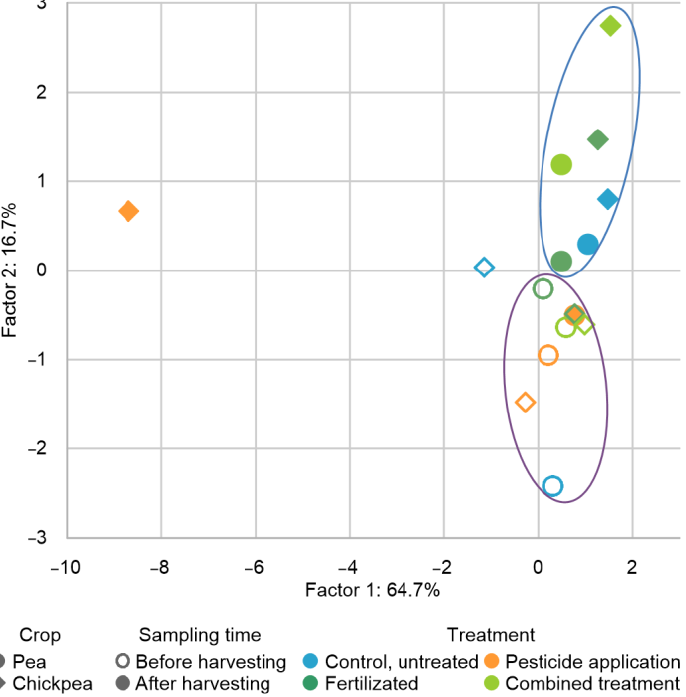
Figure 2. Principal component analysis (PCA) of bacterial community composition in soils under different experimental conditions.